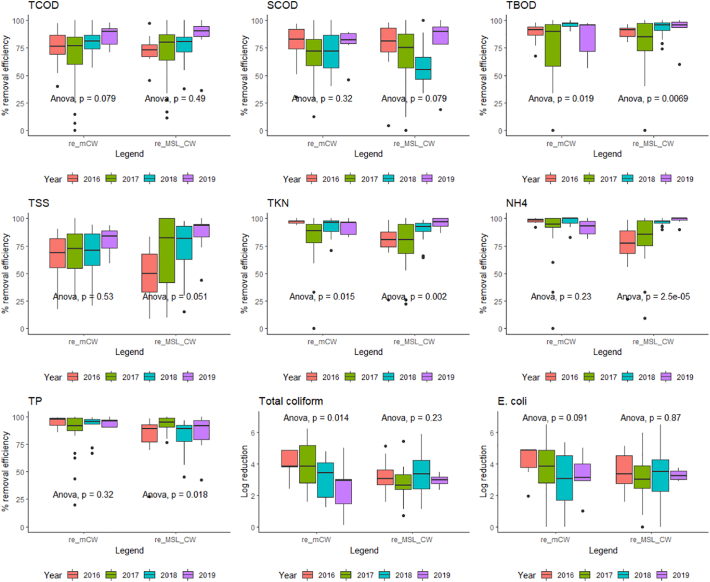
Box plots of yearly removal efficiency (re): mCW and MSL.